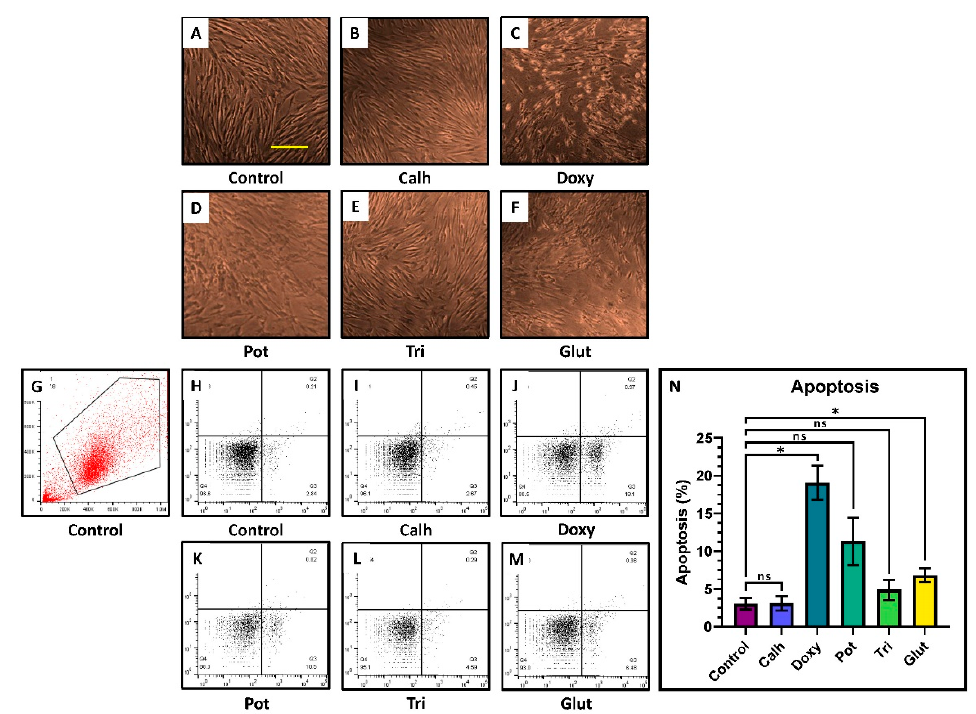
Figure 3. Morphologic and apoptosis analysis in DPSCs treated with selected concentrations of drugs. ( A – F ) Morphology of DPSCs after treatment with selected concentrations of drugs. ( G – N ) Comparative analysis of apoptosis by annexin V assay. ns is not significant; * p < 0.05.